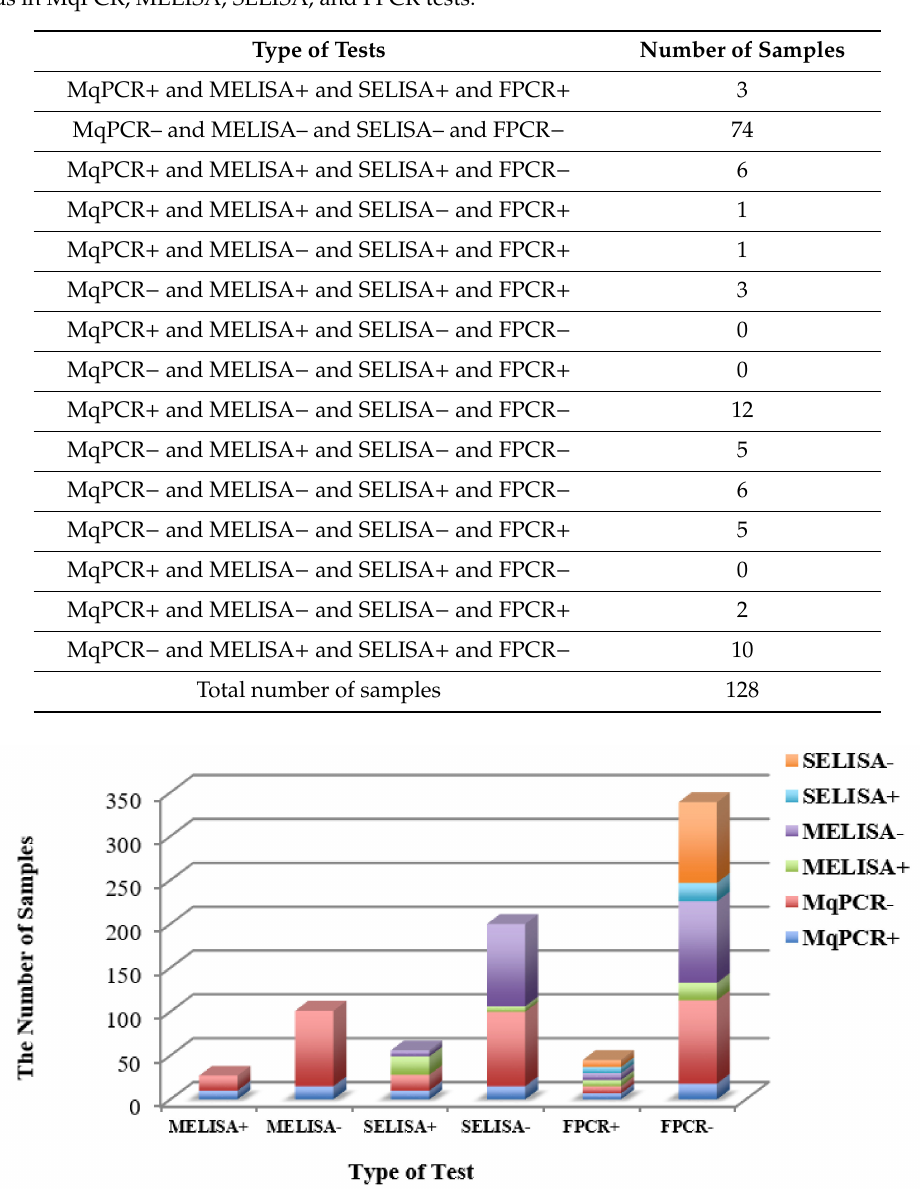
Figure 12. Distribution of 128 MIF milk samples classified into 24 binary groups based on the positive / negative status in MqPCR, MELISA, SELISA, and FPCR. The following categories had the greatest proportions: 74.22% Neg (MqPCR and FPCR), 73.44% Neg (MELISA and SELISA), 72.66% Neg (MELISA and FPCR), 71.88% Neg (SELISA and FPCR), 67.19% Neg (MqPCR and MELISA), and 66.41% Neg (MqPCR and